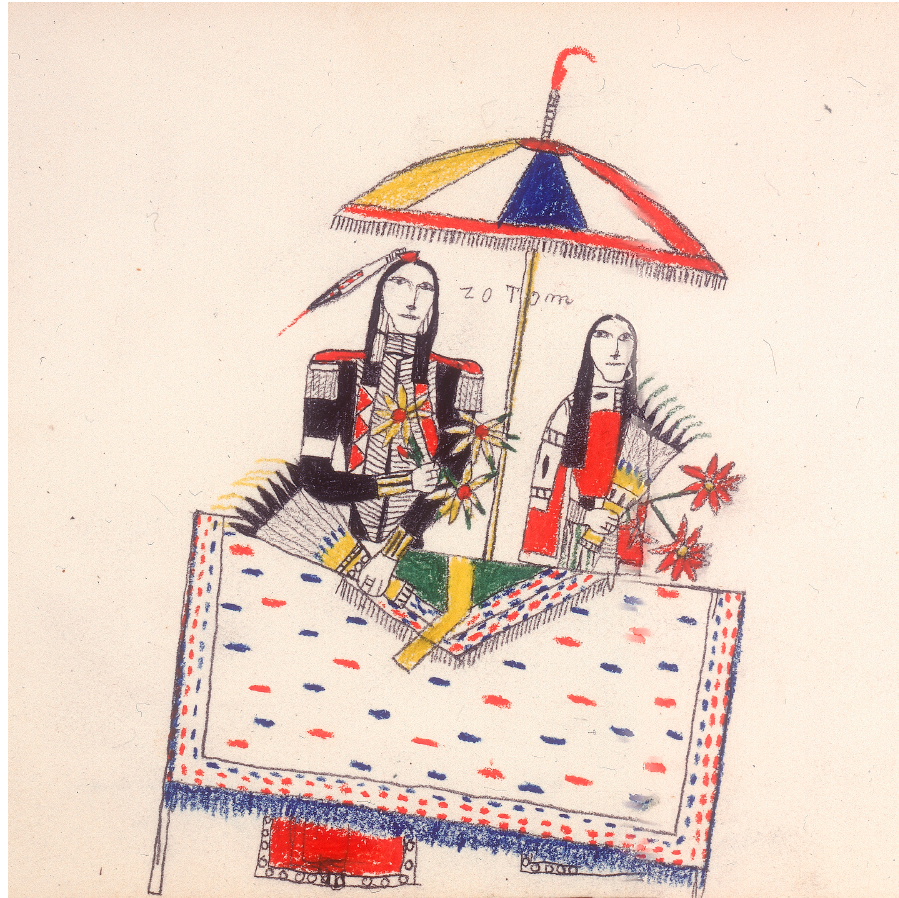
Figure 6. Zó ̱ ta ̂ m (Driftwood) with his wife prior to his imprisonment. She died while he was incarcerated. Credit: Braun Research Library Collection, Autry Museum, Los Angeles, California: 4100.G.12.